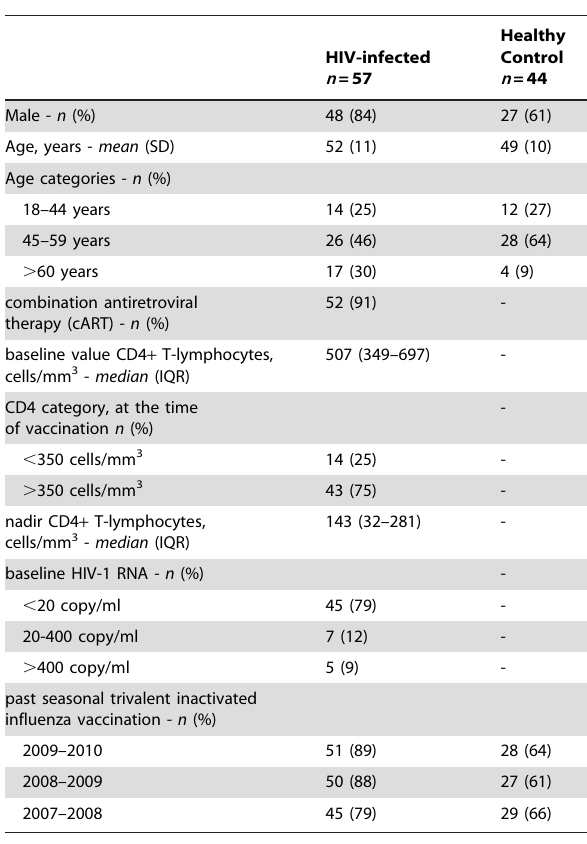
Table 1. Participant Demographics.